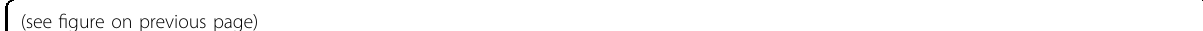
Fig. 5 Inhibition of autophagy increases adverse metabolic effects in non-lesional vitiligo cells. A , B , C Western blot of LC3-II/I, Beclin I and SQSTM1/p62 with corresponding normalized densitometric analysis on lysates of vitiligo melanocytes untreated or treated with 3MA (5 mM) for 24 – 48 – 72 – 96 h. Representative blots of three independent experiments are shown; D Immuno fl uorescence staining for Ki67 (red) and the corresponding percentage of Ki67 positive cells in vitiligo melanocytes before and after treatment with 3-MA (5 mM) for 24 – 48 – 72 – 96 h ( n = at least 700 cells per group). Nuclei were counterstained with DAPI. Scale bar: 50 μ m; E Immuno fl uorescence analysis and percentage of positive cells for Ki67 (red) in normal melanocytes before and after treatment with 3-MA (5 mM) for 24-48-72-96 h ( n = at least 700 cells per group). Nuclei were counterstained with DAPI. Scale bar: 50 μ m; F Morphological analysis of vitiligo melanocytes untreated and treated with 3-MA (5 mM) for 96 h. Arrows point at cells showing an enlarged morphology. Scale bar: 50 μ m; A representative vitiligo melanocyte culture treated with 3-MA is shown. G Western blot of p53 and p16 with corresponding normalized densitometric analysis on lysates of vitiligo melanocytes untreated or treated with 3MA (5 mM) for 24 – 48 – 72 – 96 h. Representative blots of three independent experiments are shown; H Double immuno fl uorescence analysis of p53 (green) and LC3 (red) expression in vitiligo melanocytes untreated and treated with 3MA (5 mM) for 24 and 48 h. Nuclei were counterstained with DAPI. The arrows point at cells showing p53 nuclear translocation. Scale bar: 10 μ m; A representative vitiligo melanocyte culture treated with 3-MA is shown. I mRNA transcripts of Gadd45 , p21 , p16 and IL-6 evaluated by qRT-PCR in vitiligo melanocytes untreated and treated with 3MA (5 mM) for 48 – 72 – 96 h (VHMs n = 3); L IL-6 quanti fi cation by ELISA in vitiligo and normal melanocytes untreated and treated with 3-MA (5 mM) for 48-72-96 h (VHMs n = 3 and NHMs n = 3). Gadd45 , growth arrest and DNA damage-inducible 45; IL-6, interleukin 6; LC3-I/II, (microtubule-associated protein 1) light chain 3; NHMs, normal human melanocytes; 3-MA, 3-methyl adenine; VHMs, vitiligo human